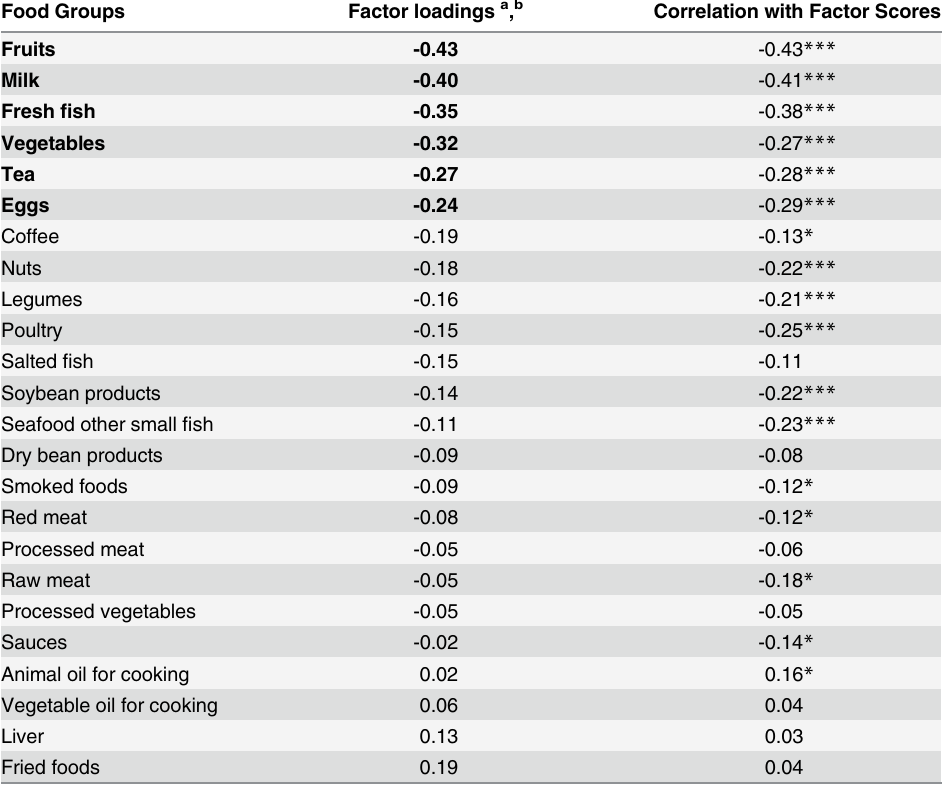
Table 2. Factor Loading Values Obtained by Partial Least Squares Discriminant Analysis Method, the Spearman Correlation Coefficients between Food Groups and Factor Scores. Food Groups Factor loadings a , b Correlation with Factor Scores Fruits